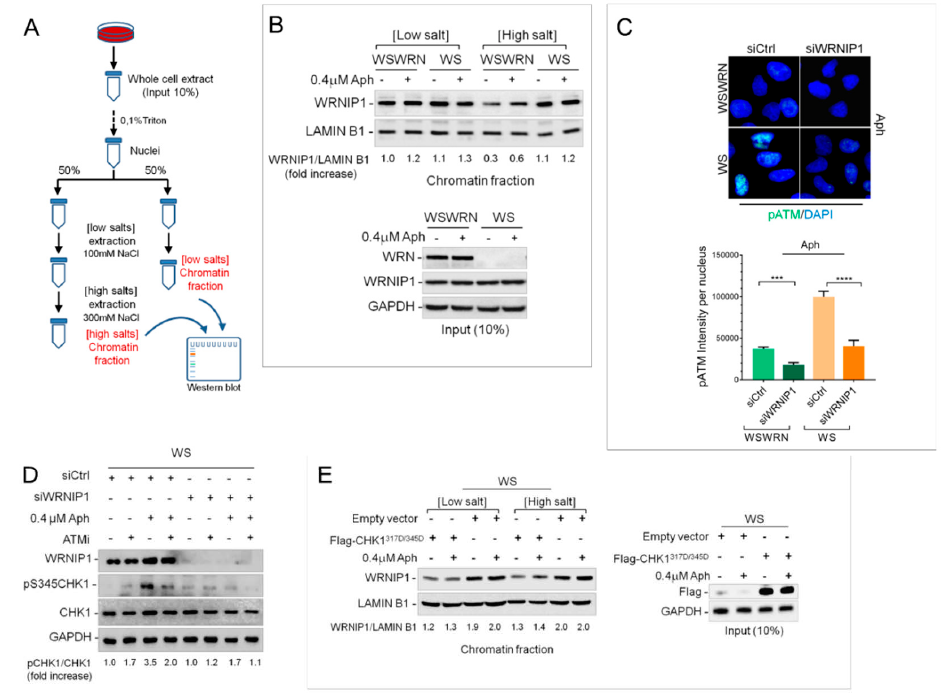
Figure 2. WRNIP1 mediates the ATM-dependent CHK1 phosphorylation in WS cells. ( A ) Schematic representation of chromatin fractionation assay; ( B ) The membrane was probed with the indicated antibodies. The amount the chromatin-bound WRNIP1 is reported as a ratio of WRNIP1 / LAMIN B1 normalized over the untreated control; ( C ) IF analysis of cells transfected with Green Fluorecent Protein (GFP) or WRNIP1 siRNA and stained for pATM (S1981). Bar graph shows pATM intensity per nucleus. Error bars represent standard error; ( D ) WB analysis of the presence of activated, i.e., phosphorylated, CHK1 assessed using S345 phospho-specific antibody (pS345) in WS cells depleted for WRNIP1 and treated with Aph. ATMi was added 1 h prior to Aph and used as a negative control. The membrane was probed with the indicated antibodies. The normalized ratio of the phosphorylated CHK1 / total CHK1 is given. ( E ) WB analysis of chromatin binding of WRNIP1, performed as in ( A ) in WS cells transfected with empty vector or FLAG-tagged CHK1317 / 345D and treated with Aph. The membrane was probed with the indicated antibodies. The normalized ratio of the WRNIP1 / LAMIN B1 signal (chromatin) is